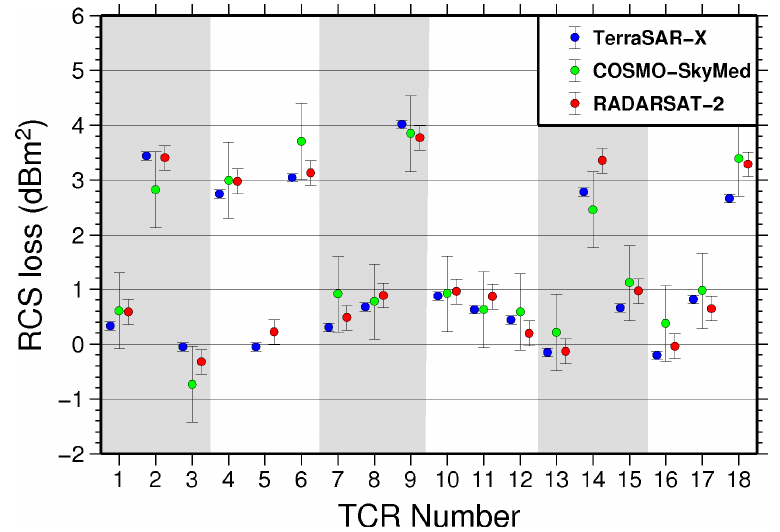
Figure 10. RCS loss due to misalignment of the TCR from the optimum boresight orientation for each SAR sensor. Misalignments for each TCR are given in Table 2. Each RCS loss is calculated by subtracting the image with misalignment from a previous image without misalignment. The RCS of four ‘control’ TCR (numbers 3, 5, 13 and 16) with no misalignment are used to derive the standard errors for each SAR sensor, which are plotted here as 2-sigma error bars. The CSK measurement for TCR number 5 is discarded from this analysis due to flooding of the TCR as described previously in the text. Background grey polygons are plotted to aid delineation of the different type groups of TCR design described in Table 2.